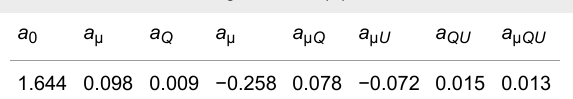
Table 7: The model coefficients determining the impact of solution dynamic viscosity (µ), solution flow rate ( Q ) and electrical voltage ( U ) on the bead-free fiber average diameter ( D